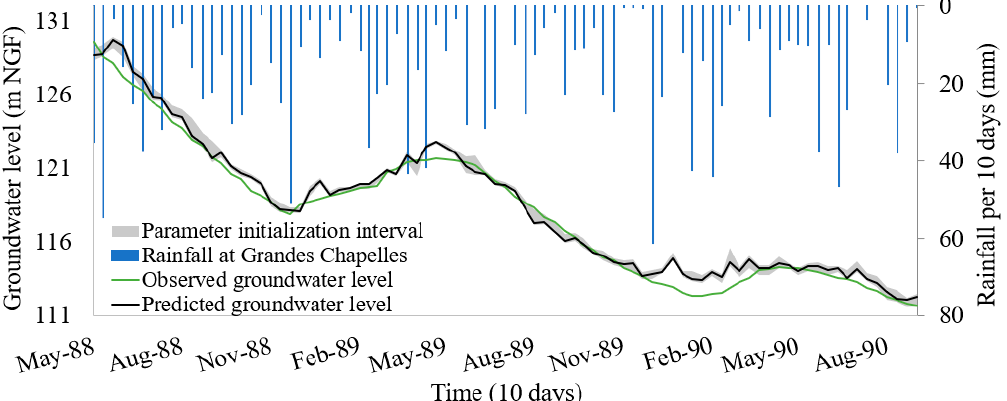
Figure 6. Prediction of groundwater levels at 20 days lead-time on the test set. The three last months of 1990 were not taken into account due to possible errors in piezometric levels. C p = 0.40; C PICP = 0.39; C MPI = 0.62 m.